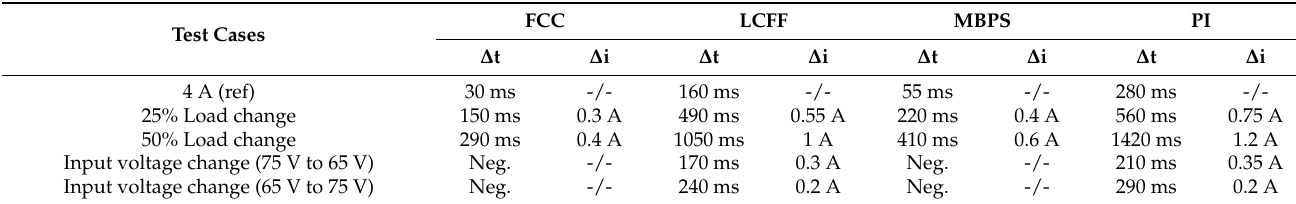
Table 4. Summary of experimental results.